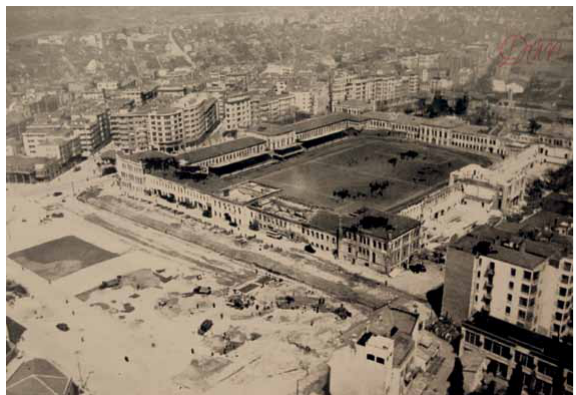
fig. 2. artillery Barracks in Taksim c. 1930s.